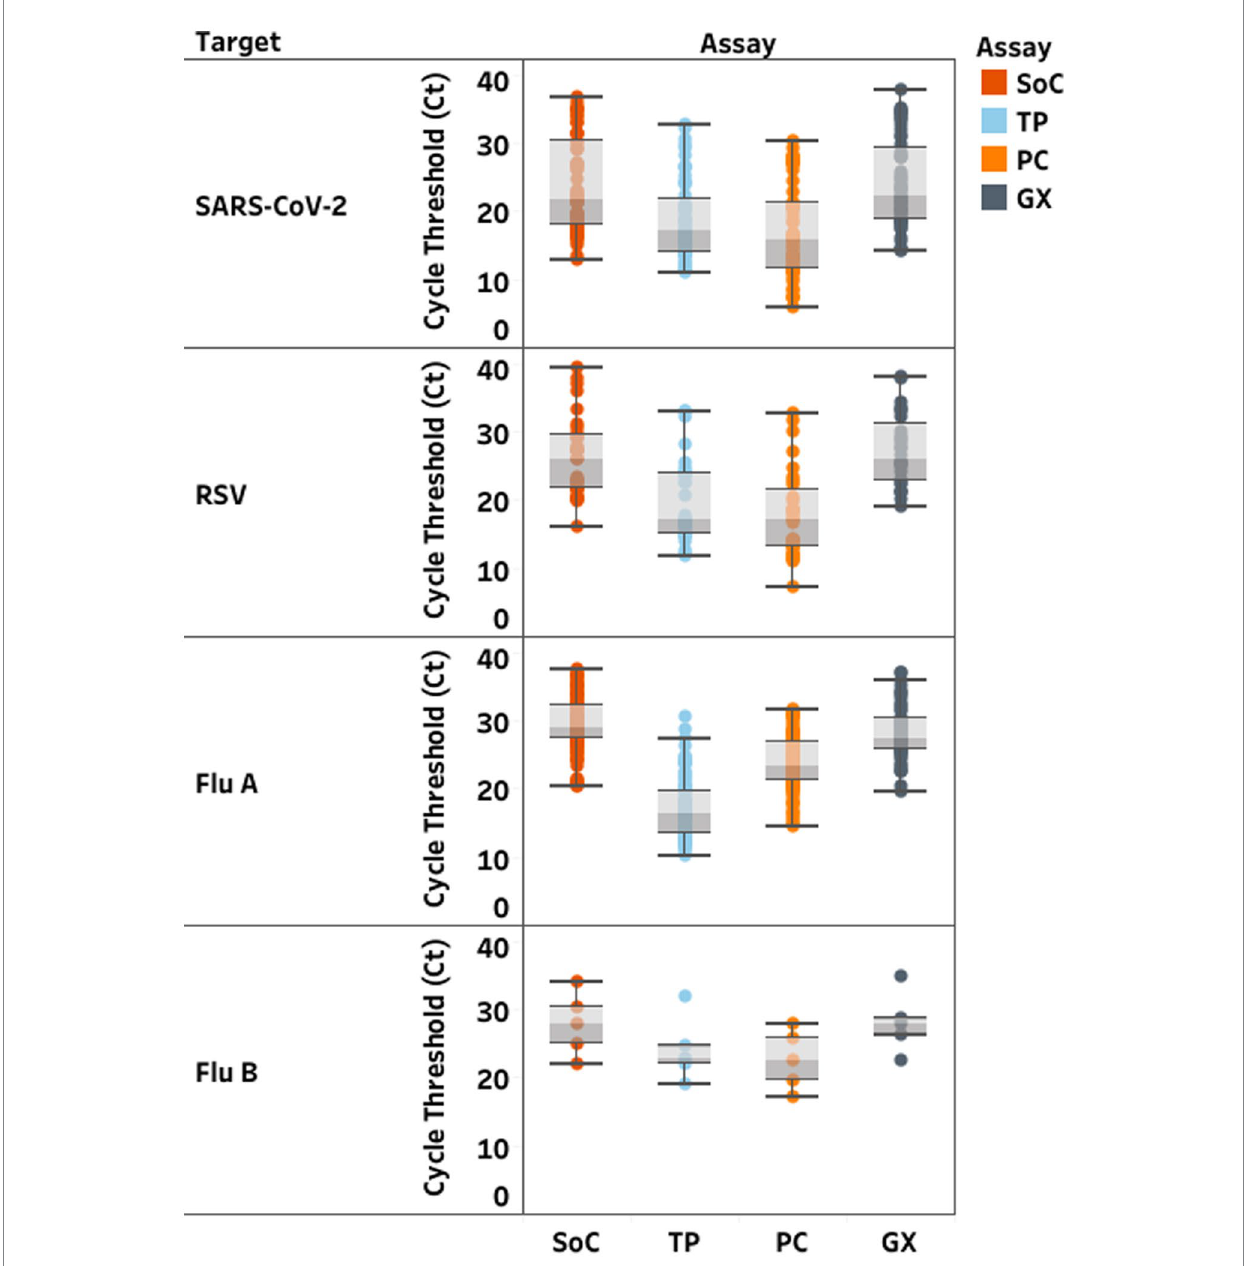
FIGURE 1 Distribution of cycle threshold (Ct)-values (median; min-max) in clinical samples according to each RT-PCR assay. Standards of Care (SoC) are displayed in dark orange, Thermofisher TaqPath ™ COVID-19, FluA/B, RSV Combo Kit (TP) in light blue, Kogene PowerChek ™ SARS-CoV-2, Influenza A&B, RSV Multiplex Real-time PCR Kit II (PC) in light orange, Cephied Xpert ® Xpress SARS-CoV-2, Flu, RSV Kit (GX) in grey. Ct values are displayed for severe acute respiratory syndrome coronavirus 2 (SARS-CoV-2),